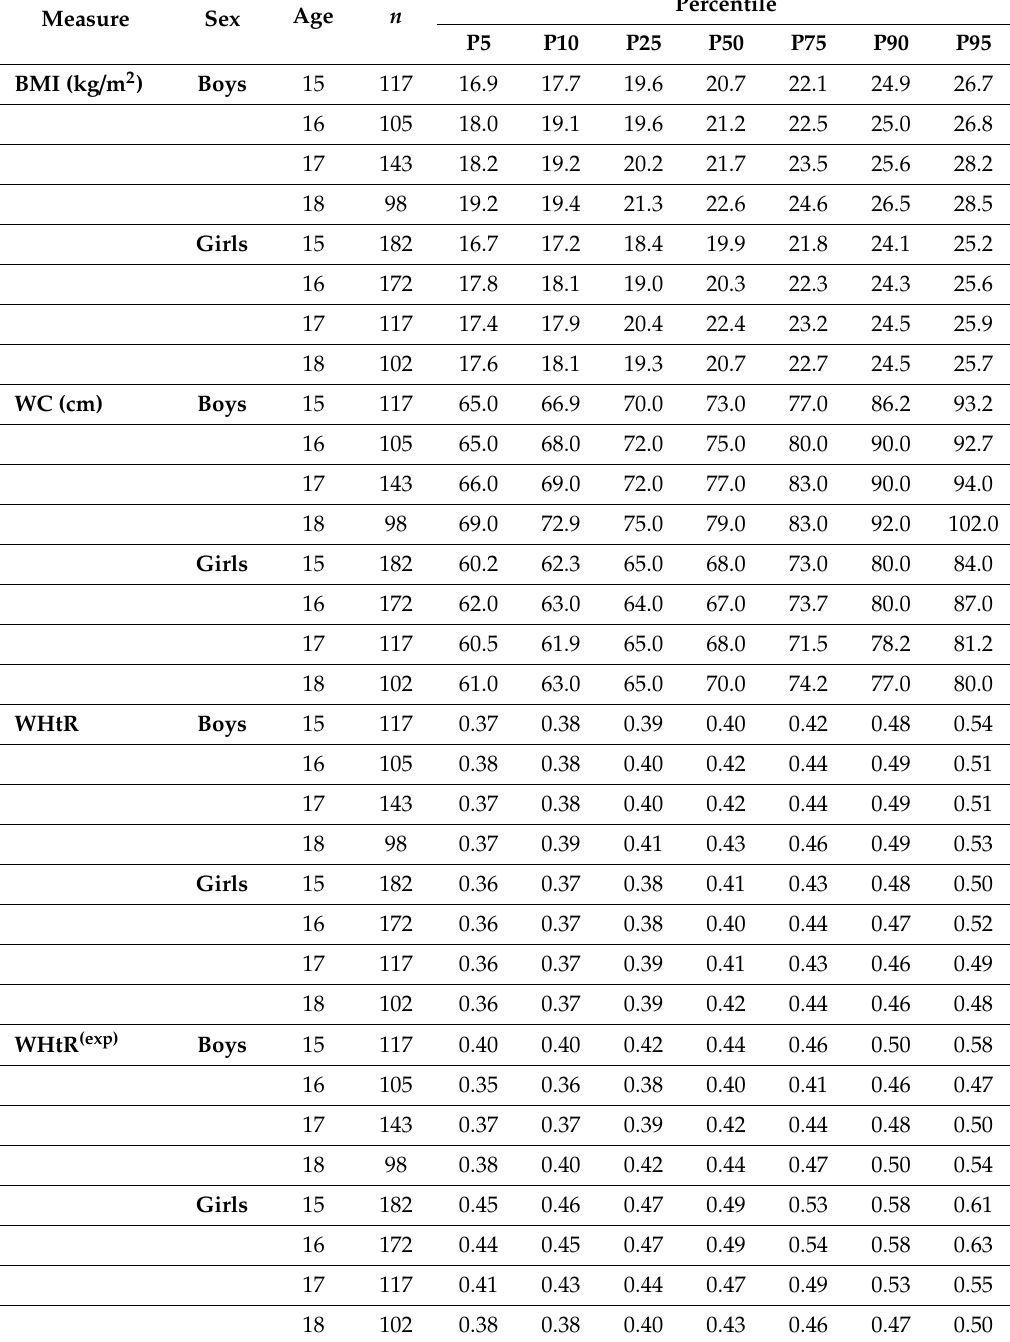
Table 2. Sex- and age-specific percentiles body-mass index (BMI), waist circumference (WC) and waist-to-height ratio (WHtR) and WHtR (exp) (Croatia, 2019). Measure Sex